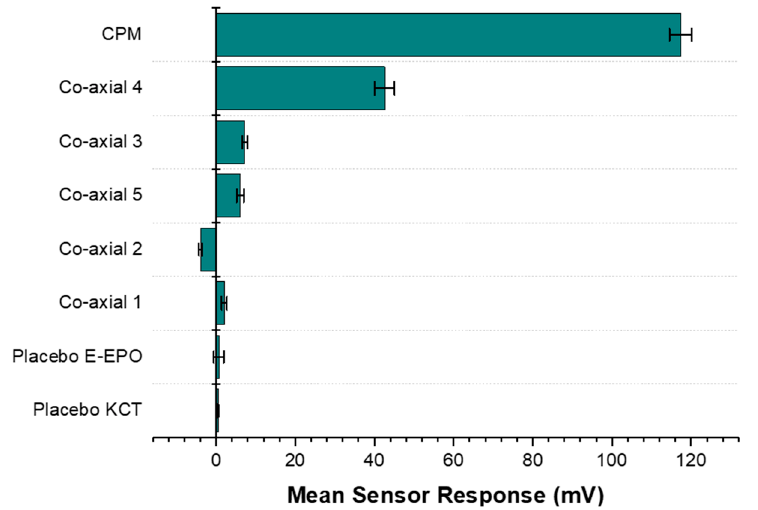
Figure 15. A bar chart representing the E-tongue’s response to the various formulations also tested placebo fibres. The sensor used for this assessment was BT0, the newest generation basic bitterness